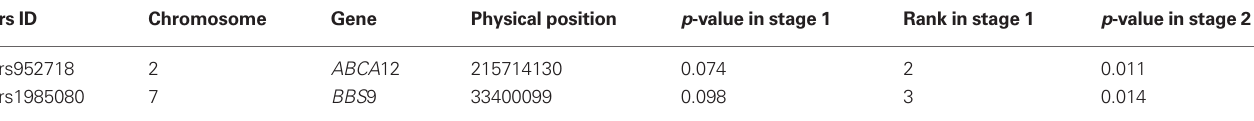
Table 4 | The association results of ancestry informative markers with height at a nominal level of 0.05 by the two-stage procedure. rs iD Chromosome